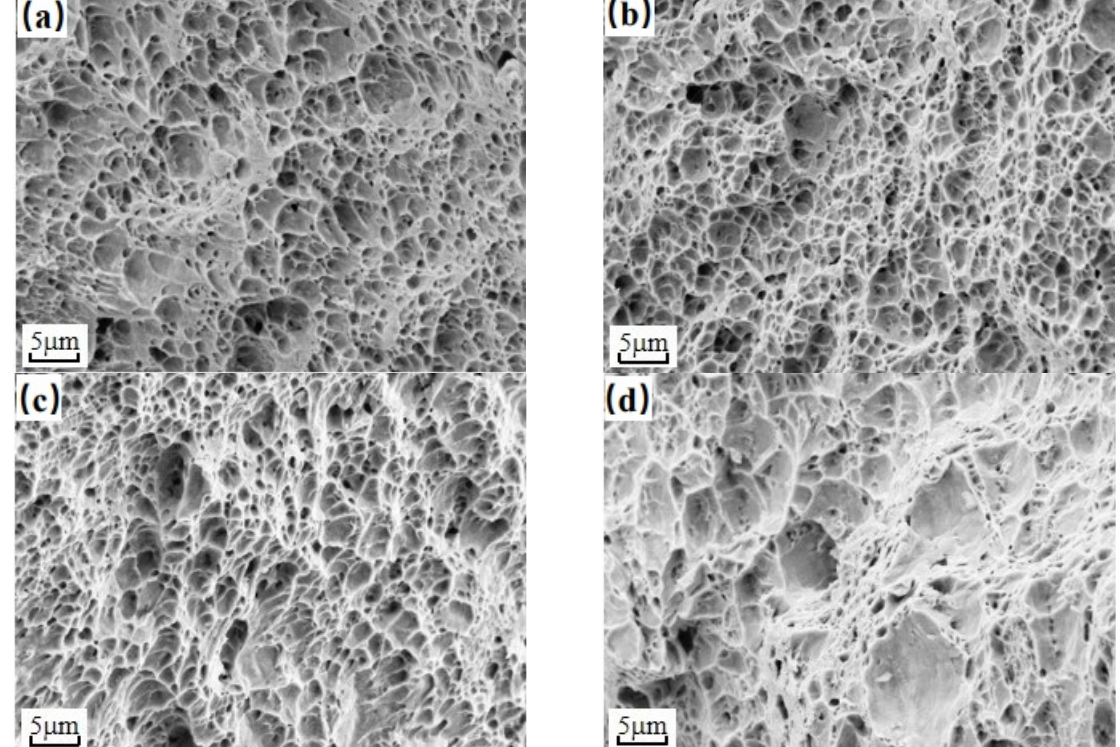
Figure 6. Fracture morphology of different regions of the welded joint. ( a ) WS; ( b ) CGZ; ( c ) FGZ; ( d ) BM.